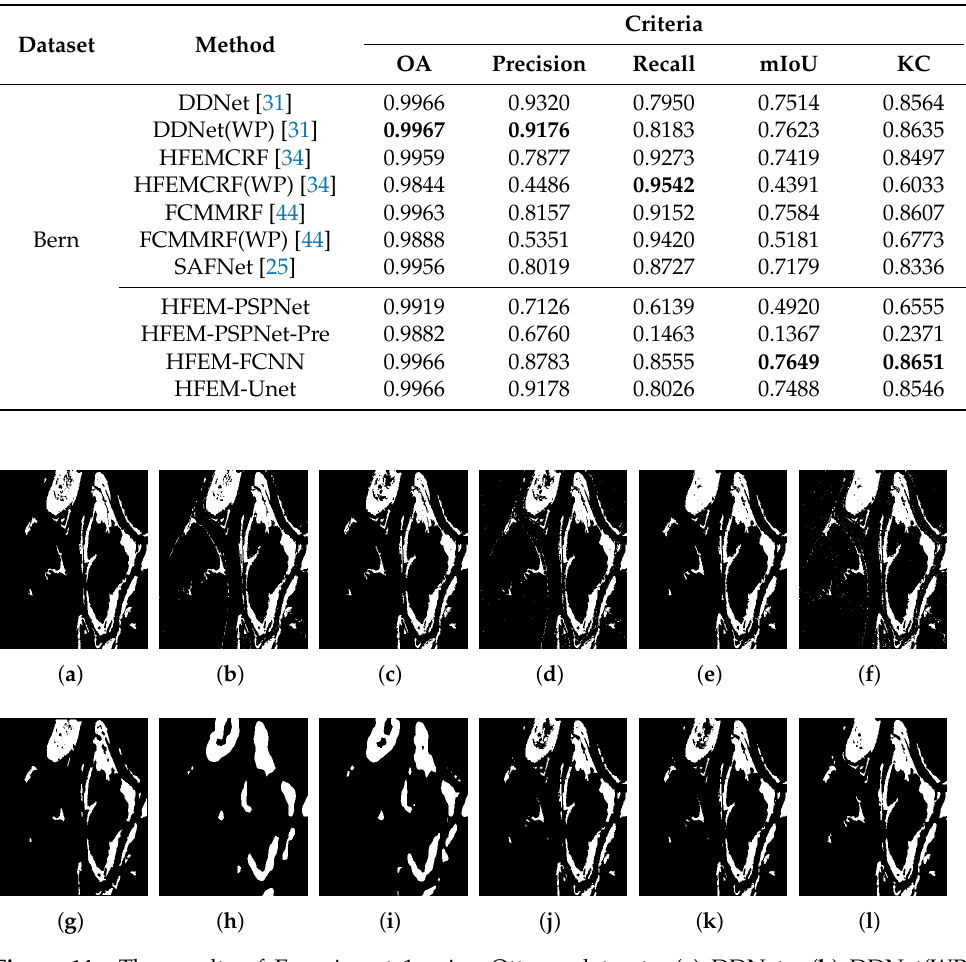
Figure 14. The results of Experiment 1 using Ottawa dataset. ( a ) DDNet. ( b ) DDNet(WP). ( c ) HFEMCRF. ( d ) HFEMCRF(WP). ( e ) FCMMRF. ( f ) FCMMRF(WP). ( g ) SAFNet. ( h )